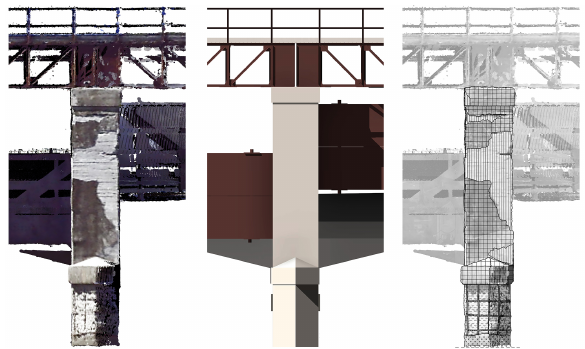
Figure 8. State of deterioration of a pillar (orthophotos, BIM Model and